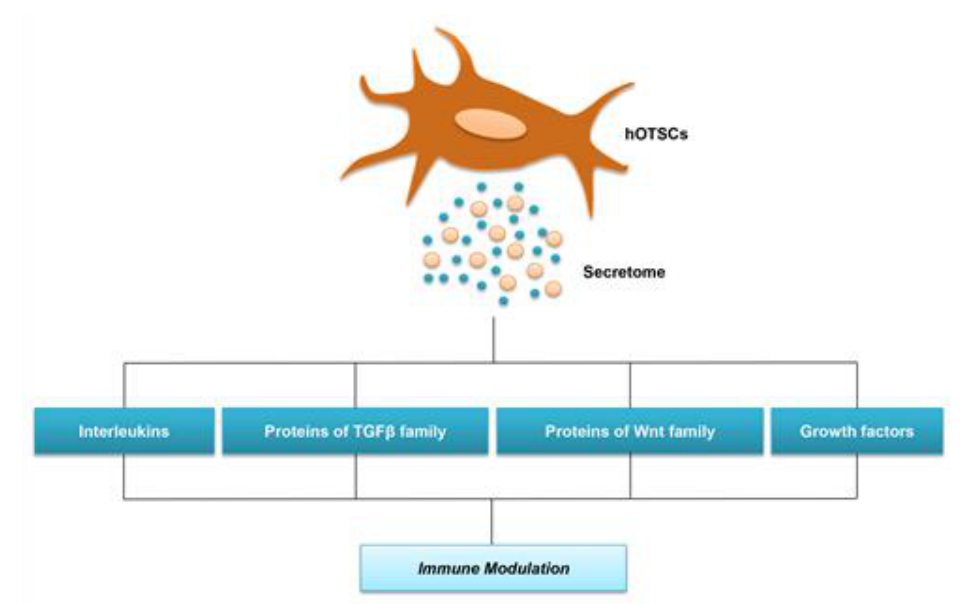
Figure 2. Human OTSCs secretome. Family subgroup of proteins released from the hOTSCs secretome. Table 1. Family subgroup of proteins released from the hOTSCs secretome .